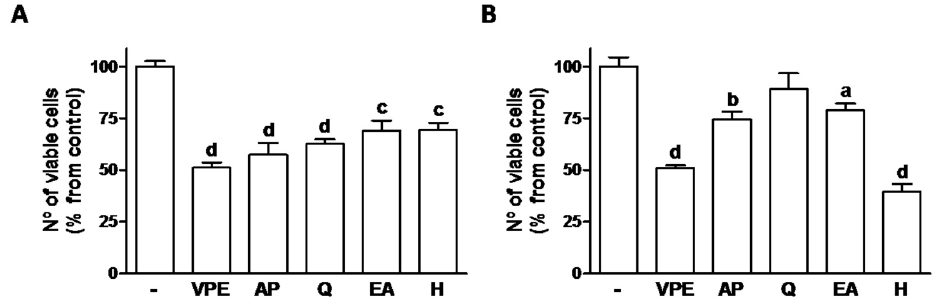
Figure 1. Effect of 48 h exposure to VPE (IC 50 ) and of its major constituents (as present in respective IC 50 s–see Table 3) on cell viability of HCT116 ( A ) and RKO ( B ) cells, as measured by the MTT assay. Values are expressed as mean ± SEM of three independent experiments. Letters represent statistical significance: a p ≤ 0.05, b p ≤ 0.01, c p ≤ 0.001, d p ≤ 0.0001 when compared with control by one-way ANOVA.